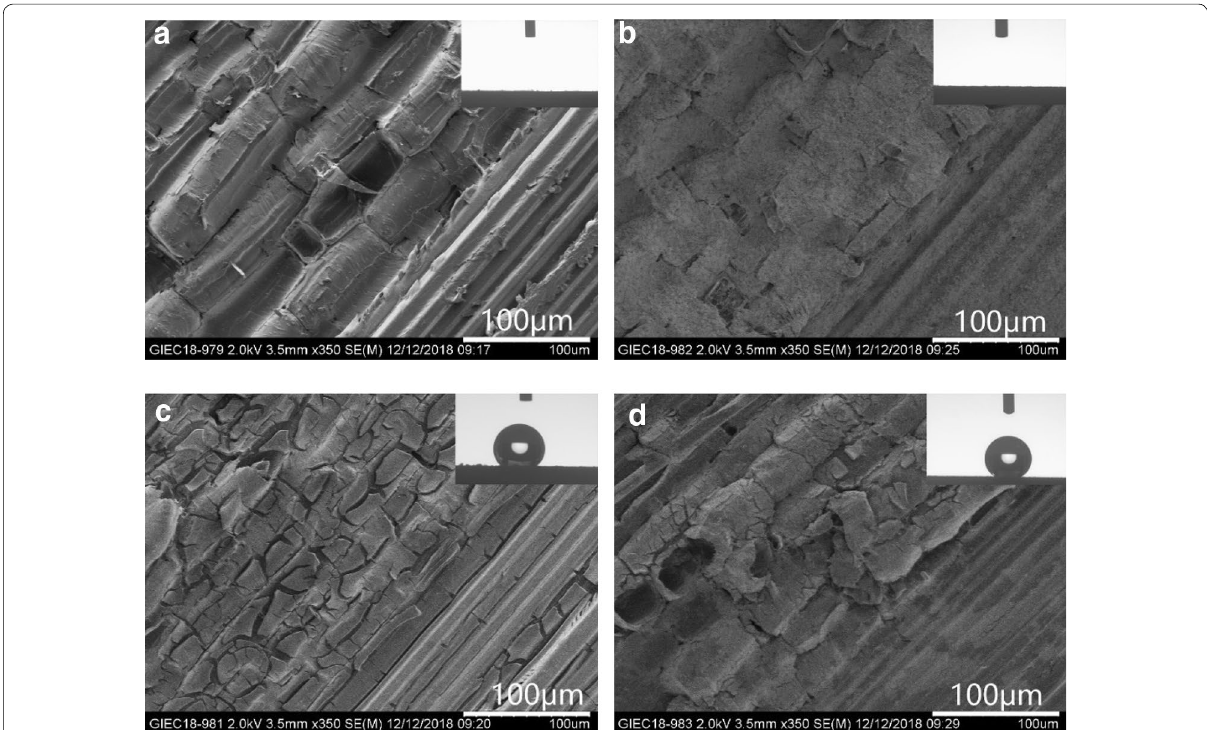
Fig. 9 SEM images of unmodified bamboo ( a ) and modified bamboo with Cu(OH) 2 ( b ), PMS ( c ) and PMS/CuNP ( d ) with corresponding WCA images